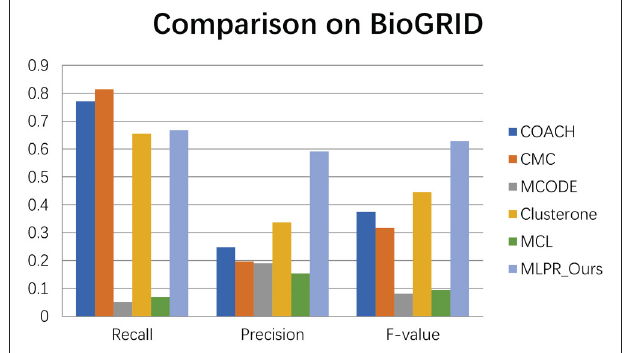
FIGURE 3 | The performance of our MLPR method on our reconstructed PPINs.